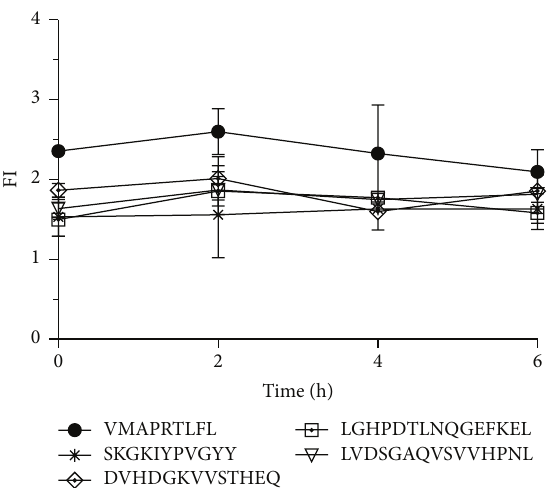
Figure 3: Noncanonical peptides provide stable HLA-E surface levels. T2E cells were incubated with test peptides and HLA-E surface levels were determined at four different time points with 0, 2, 4, and 6 h after the peptide stabilization assay ± SEM. The four noncanonical peptides were incubated with a concentration of 300 𝜇 M, the HLA-G peptide with 200 𝜇